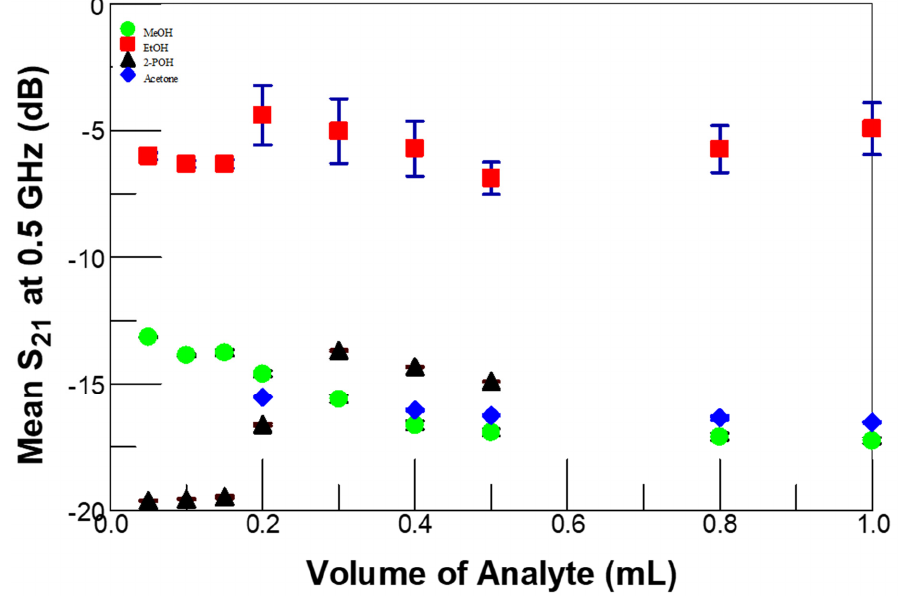
Figure 5. Comparison of analyte concentration dependence of microwave insertion loss amplitude (S 21 ) TCNQ-loaded HKUST-1 SURMOF on Si substrate at 65 °C in air, monitored at 0.5 GHz. The error bars represent the standard deviation of at least three measurements.